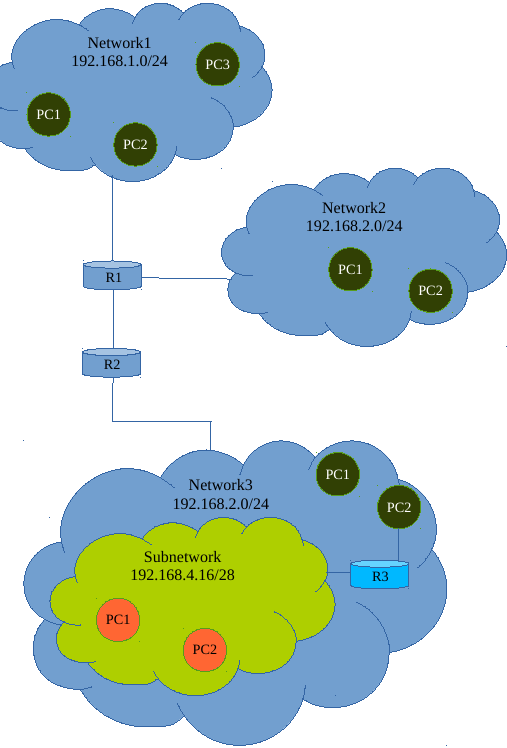
Fig. 4: Network and subnetwork example with nodes